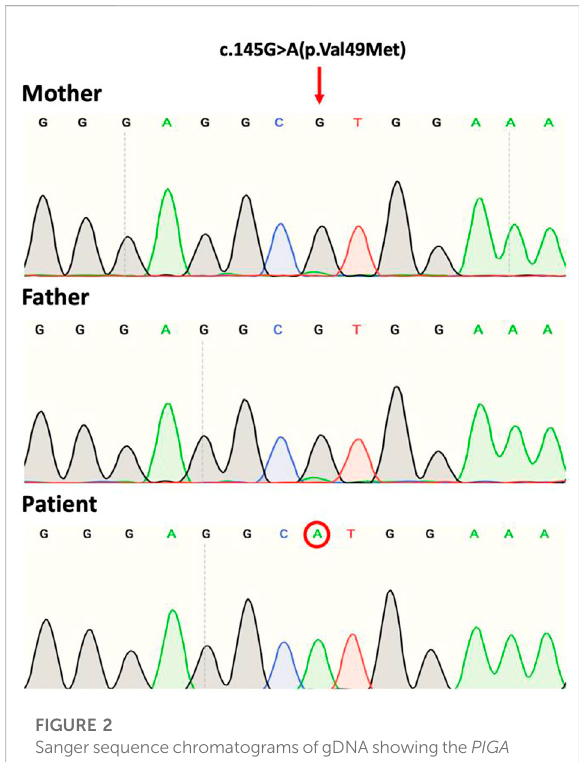
FIGURE 2 SangersequencechromatogramsofgDNAshowingthe PIGA variant NM_002641.4(PIGA):c.145G > A (p.Val49Met). The patient shows the mutation at codon position 49 of exon 2. Both mother and father are